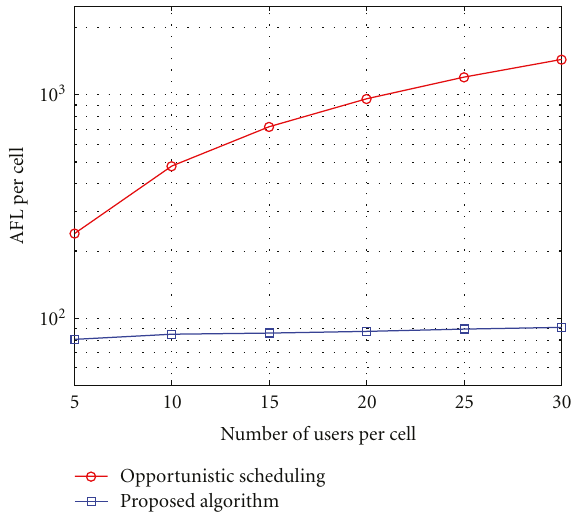
Figure 7: Comparison of AFL per cell for the proposed algorithm and the opportunistic scheduling based on instantaneous CSI with edge SNR of 10